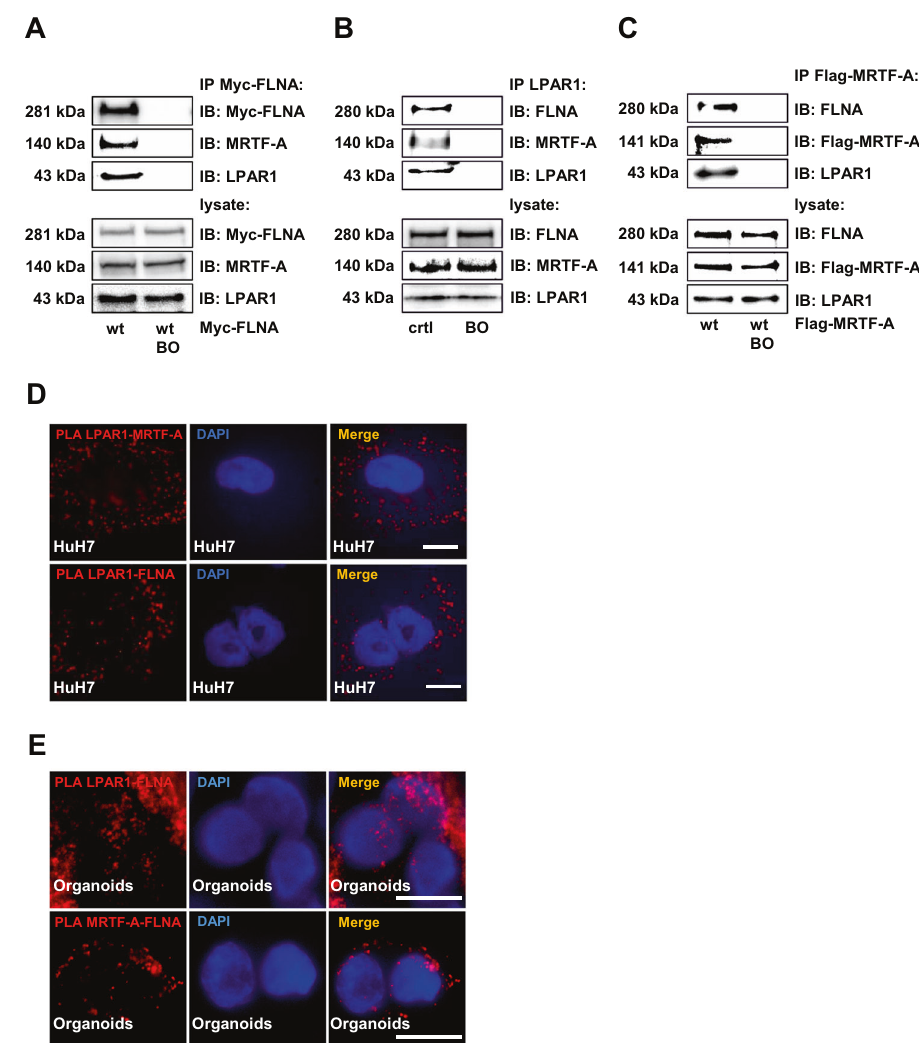
Fig. 4 Identi fi cation of LPAR1 as a novel interaction partner of FLNA and MRTF-A. A Immunoprecipitation (IP) for Myc-FLNA in HuH7 cells expressing Myc-FLNA wt and immunoblot (IB) for Myc-FLNA, LPAR1, and MRTF-A. BO: Dynabeads-only control, without antibody. B Immunoprecipitation (IP) for endogenous LPAR1 in HuH7 cells and immunoblot (IB) for FLNA, MRTF-A, and LPAR1. BO: Dynabeads-only control, without antibody. C Immunoprecipitation (IP) for Flag-MRTF-A in HuH7 cells expressing Flag-MRTF-A. Anti-FLNA, anti-Flag-MRTF-A, and anti-LPAR1 antibodies were used for the immunoblot (IB). BO: Dynabeads-only control, without antibody. D Representative images of proximity ligation assay (PLA) for endogenous LPAR1 and MRTF-A (top) and LPAR1 and FLNA (bottom) signals in HuH7 cells. DAPI was used for nuclei staining. Scale bar: 10 µm. E Representative images of proximity ligation assay for endogenous LPAR1 and FLNA (top) and MRTF-A and FLNA (bottom) signals in organoids. DAPI was used for nuclei staining. Scale bar: 10 LPA-induced expression of SRF and SM22 both on mRNA and protein levels (Fig. 3I). These results show that LPA-inducible FLNA phosphorylation at Ser 2152 promotes MRTF-A – FLNA interaction and MRTF/SRF target gene expression.